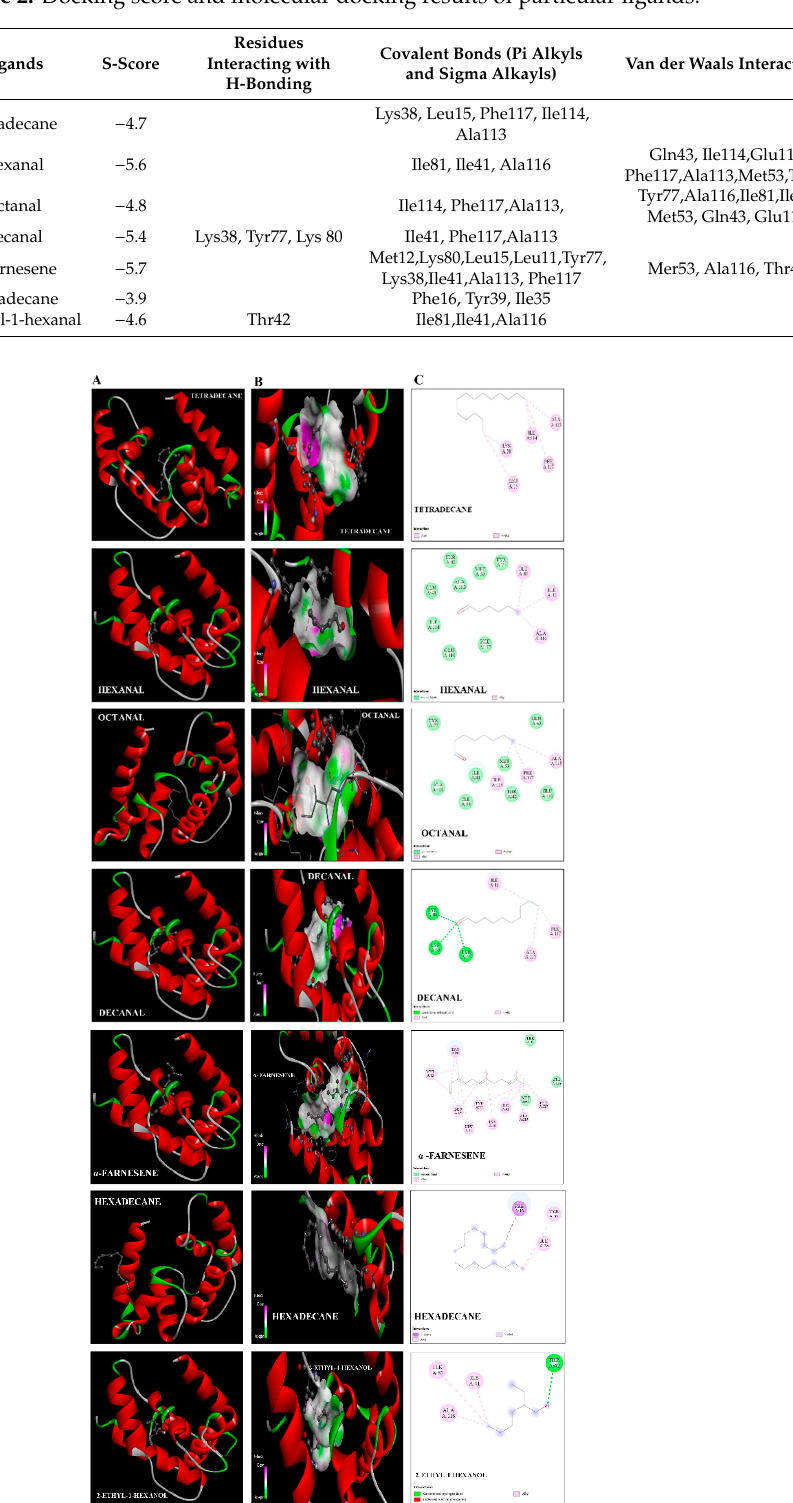
Table 2. Docking score and molecular docking results of particular ligands.